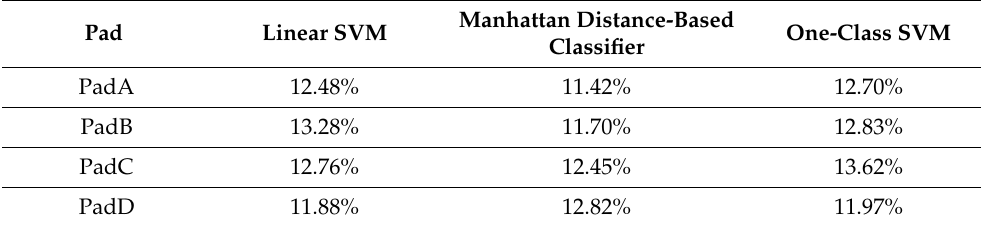
Figure 6. EER for removal of the lower 10% features. Table 4. EER for removal of the lower 10%